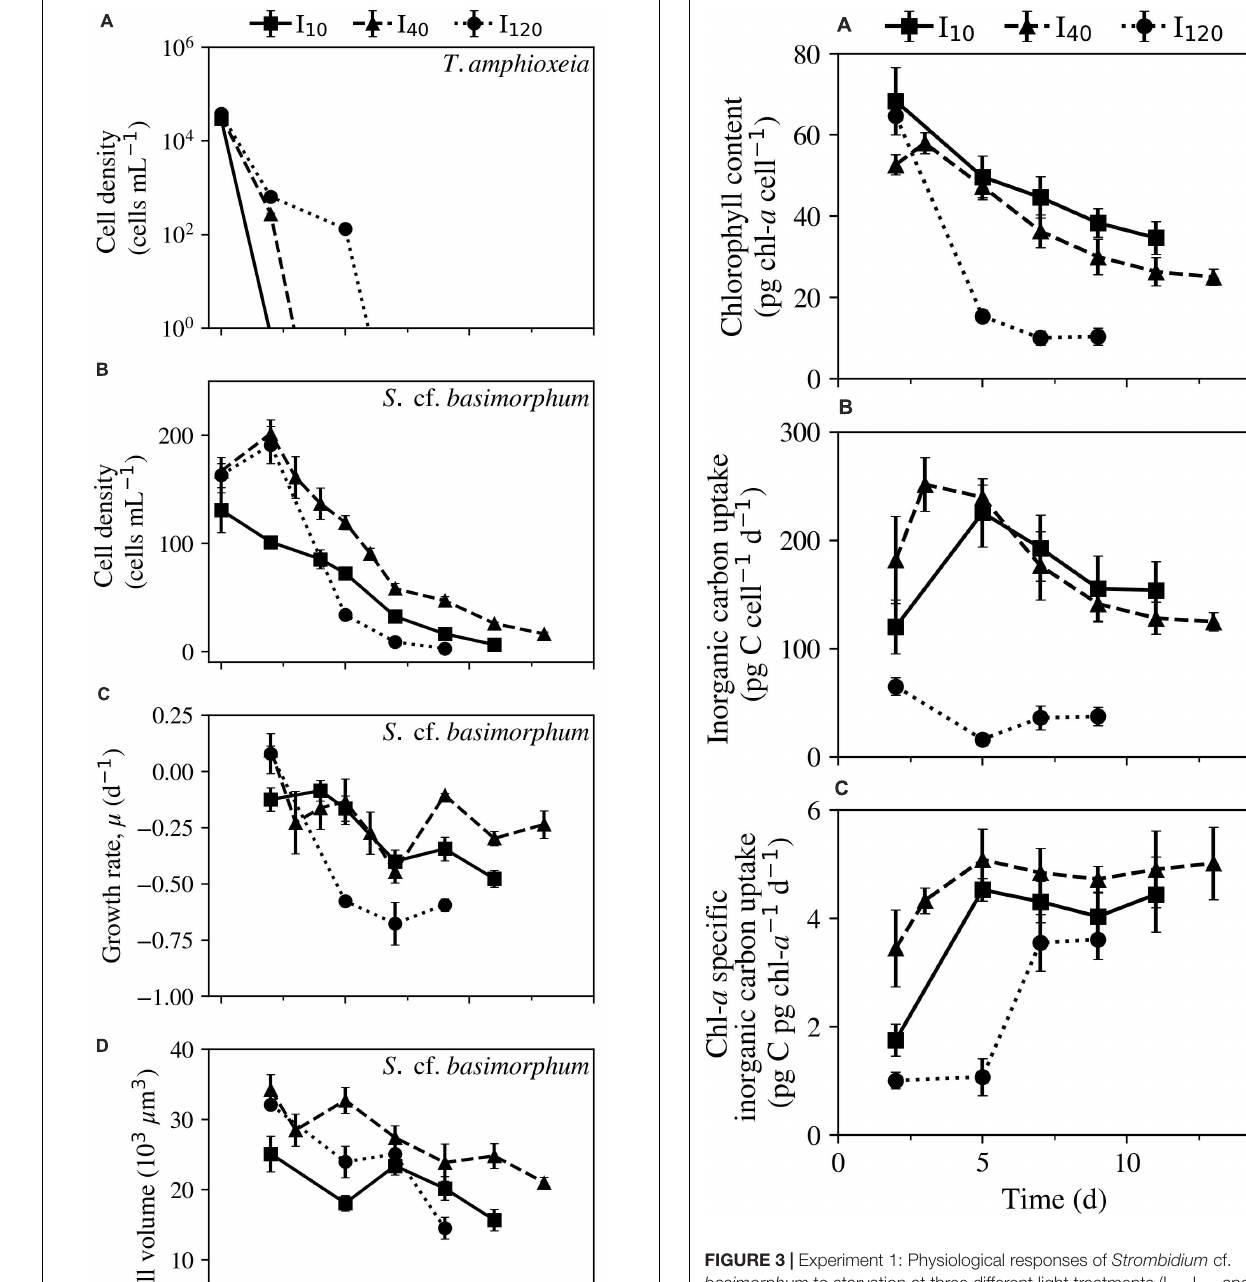
other two light treatments and ranged from 16.2 to 65.1 pg